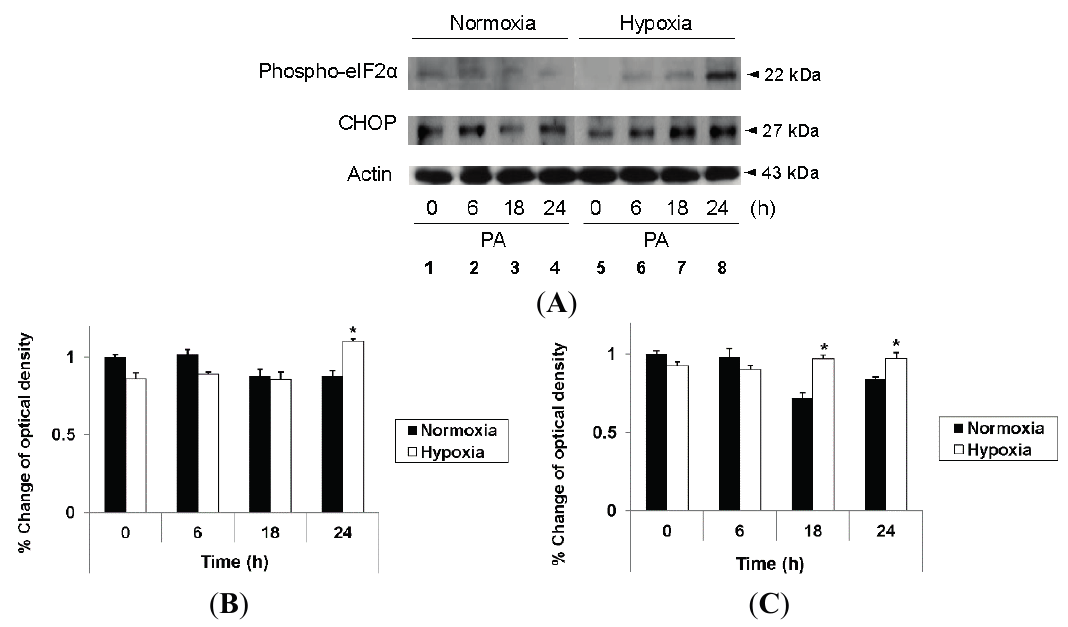
Figure 3. Enhanced PA-induced activation of caspase 9 and JNK in hypoxic hepatocytes. HepG2 cells were cultured with PA (1 mM) under either standard or hypoxic culture conditions for the indicated time periods. Immunoblot analysis was performed using anti-caspase 7, anti-caspase 8, anti-caspase 9 and anti-actin antibody ( A ); and anti-phospho-JNK and anti-JNK antibody ( B ).